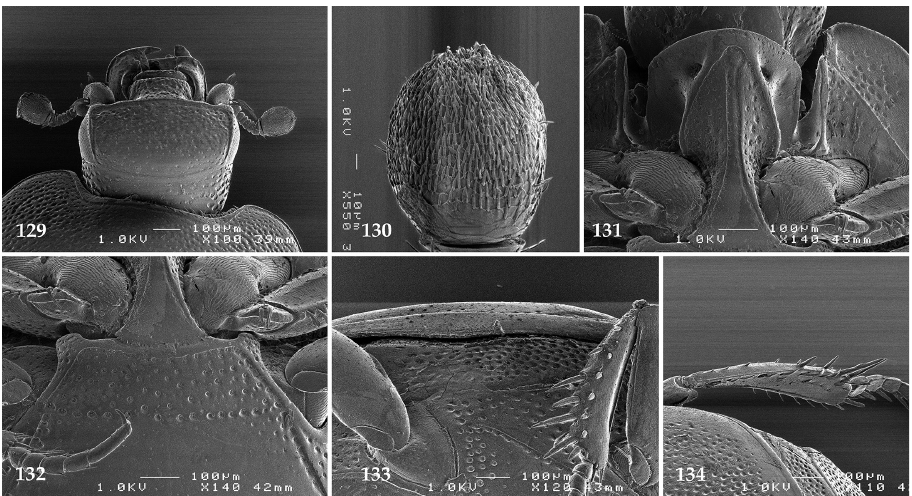
Figures 129–134. 129 Hypocaccus ( Nessus ) interpunctatus interpunctatus (Schmidt, 1885) head, dorsal view 130 antennal club, dorsal view 131 prosternum 132 mesoventrite 133 lateral disc of metaventrite + metepisternum, with visible mesotibia 134 metatibia, dorsal